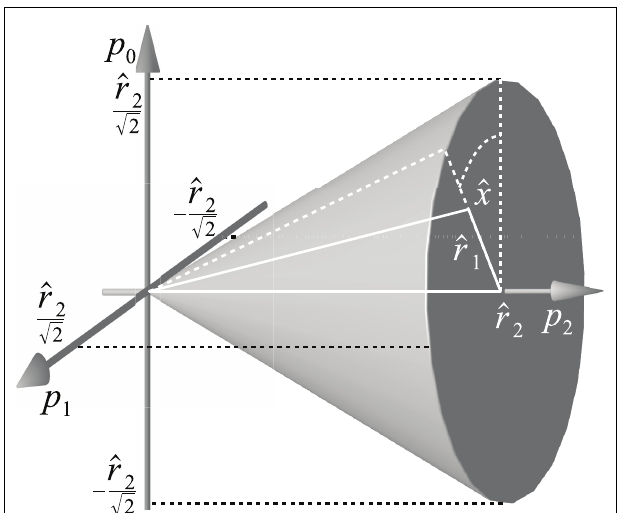
2005), are three-folded representations, see Section 1. In Figure 3 , the color opponent transform, an orthogonal transformation of RGB, is illustrated.